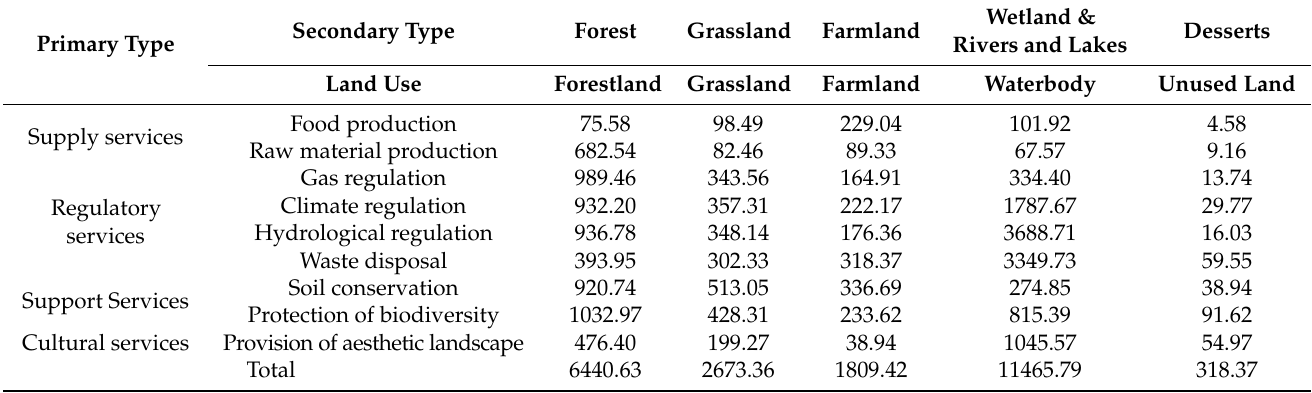
Table 1. The ecological service value per unit area of the ecosystem in Taiyuan